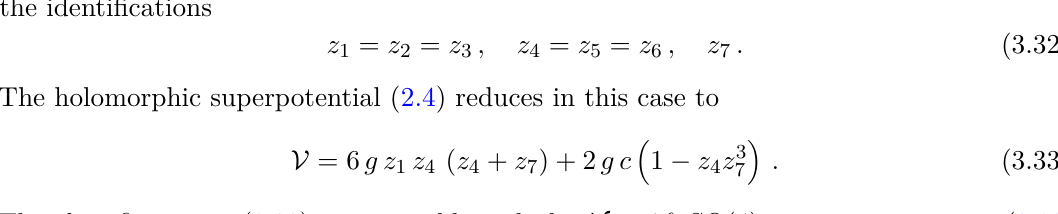
(left), ˜ z (middle) and ˜ z (right). The N = 4 & SO(4) 1 4 7 = 1 . The red flow corresponds 1 | . Black dots in the middle and crit = ˜ z are real-valued, and correspond to the 4 7 and ˜ z . In our 1 4